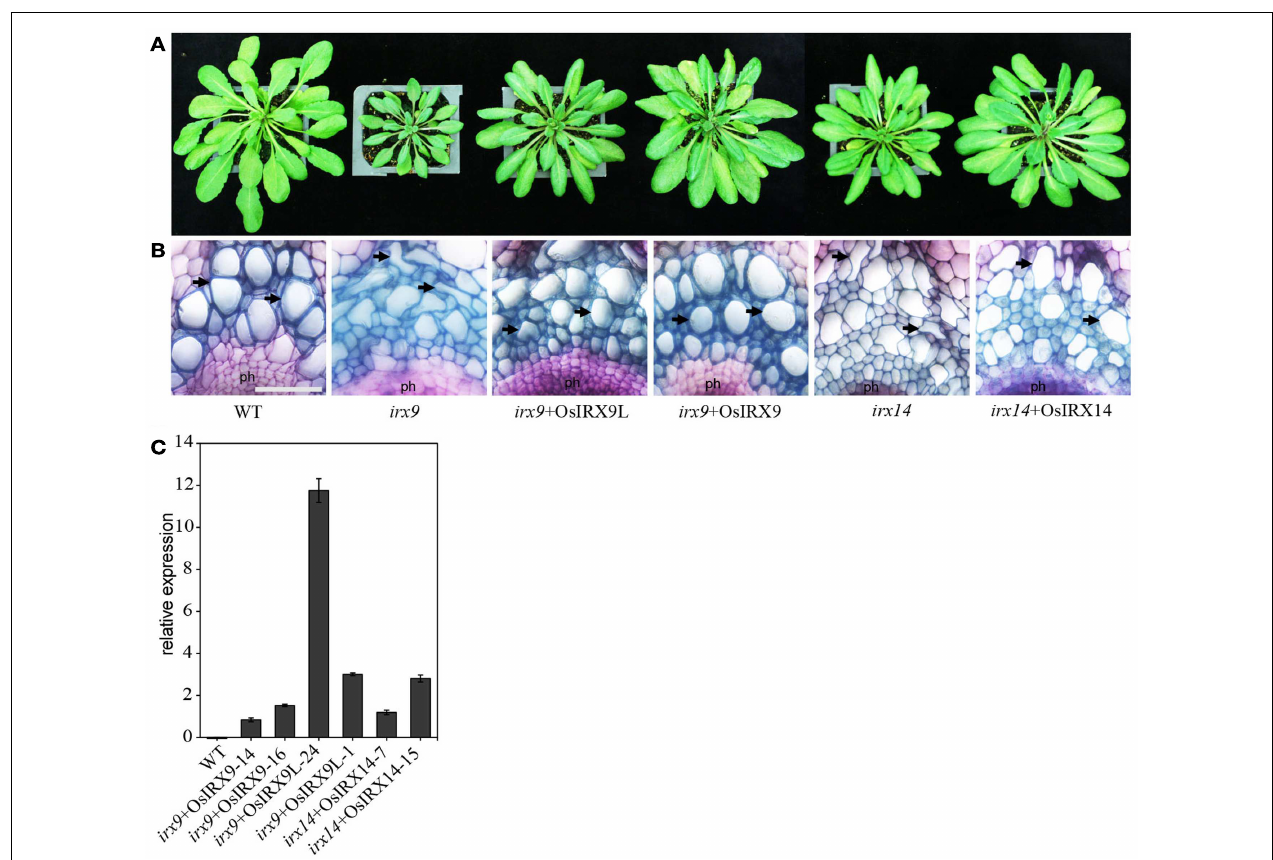
expression of each rice gene in the complemented Arabidopsis lines.The relative expression levels were examined for 10 lines in each construct.Two lines (shown) with the highest expression for each construct were chosen for further analysis. Error bars represent SD of three biological